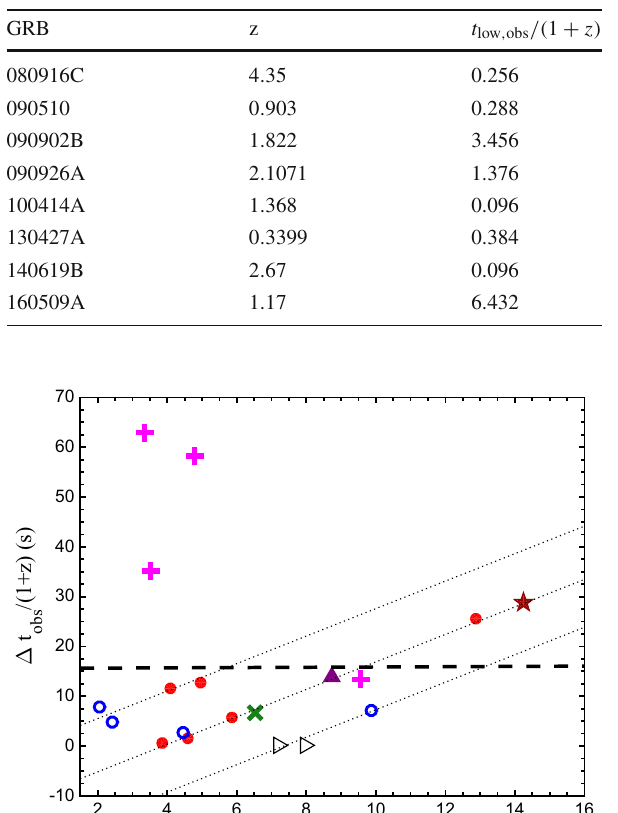
Table 3 The t low , obs /( 1 + z ) determined by the energy criterion (Cri-